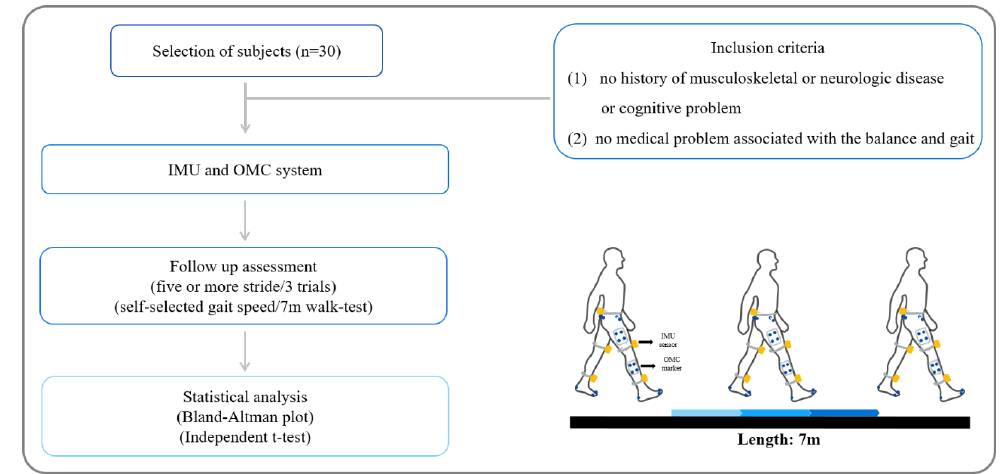
Figure 2. Schematic diagram of gait analysis using the IMU system and OMC system.